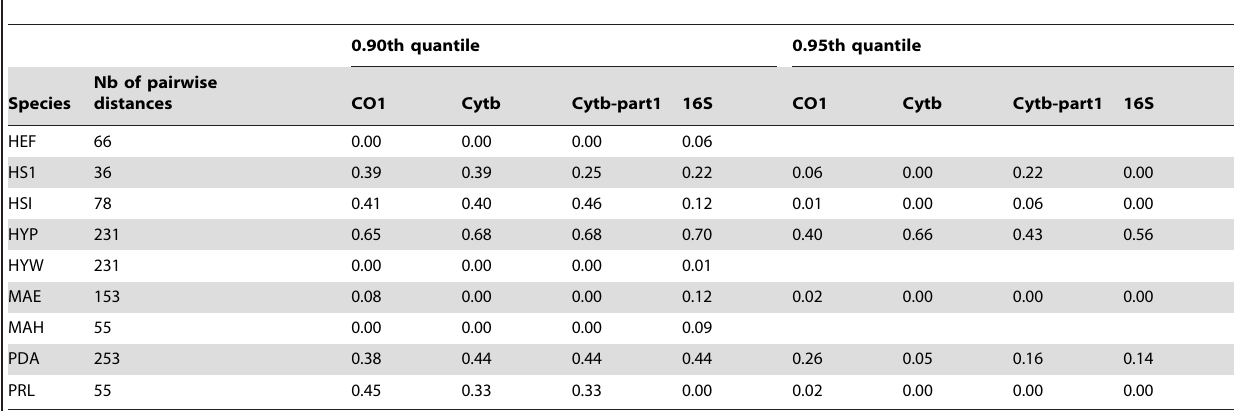
Table 3. Proportion (%) of the pairwise distances belonging to the 0.90 th and 0.95 th quantile of the distribution of the intraspecific pairwise